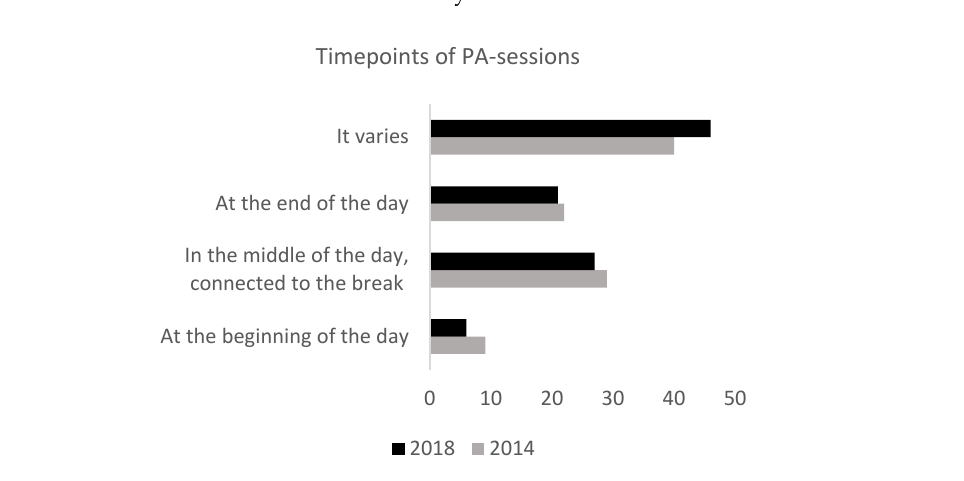
Figure 4. An overview of what time of day the PA sessions were conducted in 2014 and 2018. The figure shows the percentage of responses from the schools (2018: n = 65, 2014: n = 69).